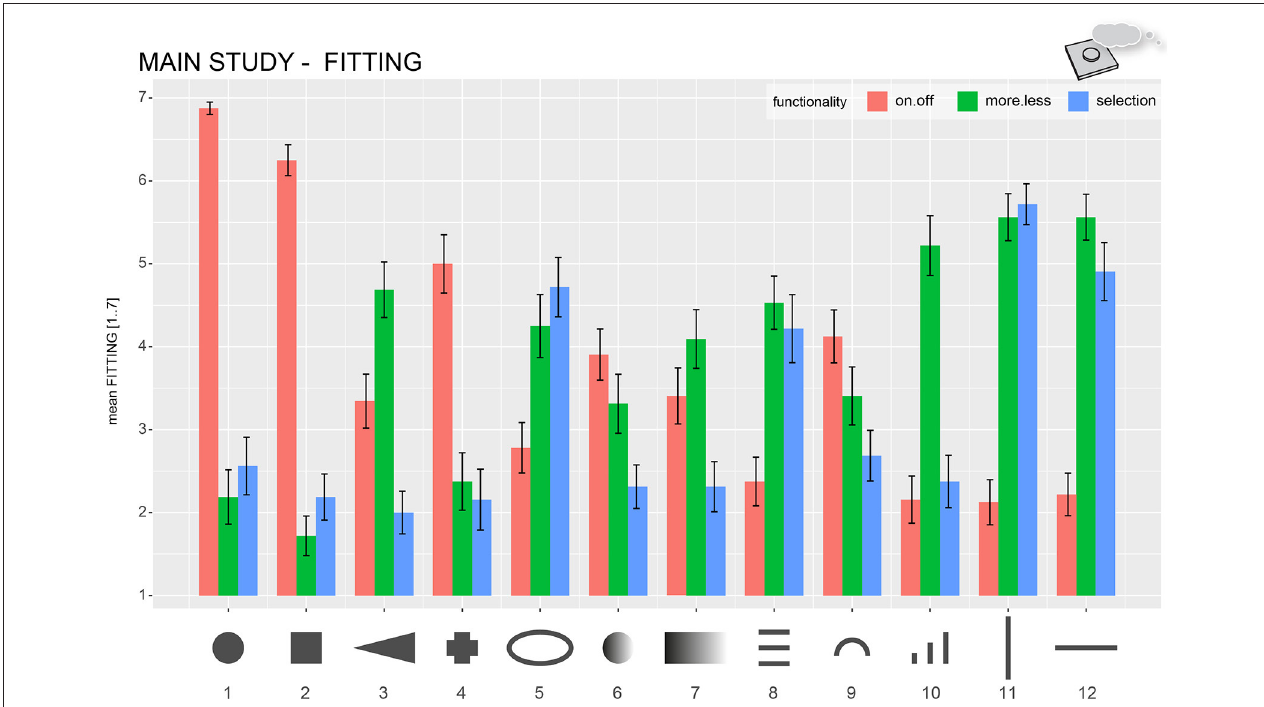
FIGURE 10 | Mean fitting values for all functionality categories (on/off, more/less, selection) for each haptic form. Error bars indicate ± 1 standard error of the